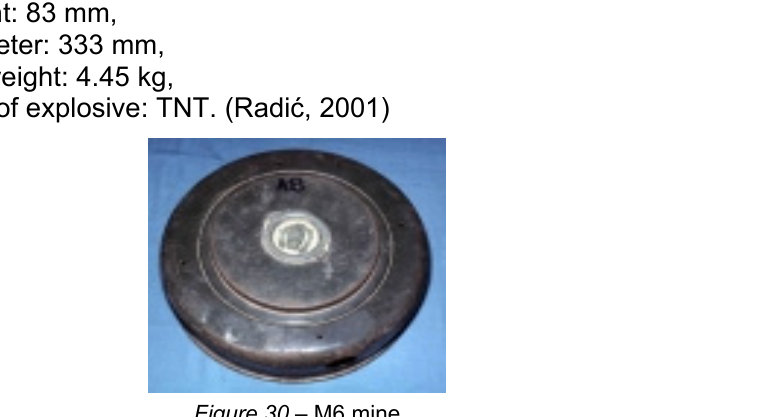
Figure 30 – M6 mine Рис . 30 – Мина М 6 Слика 30 – Мина